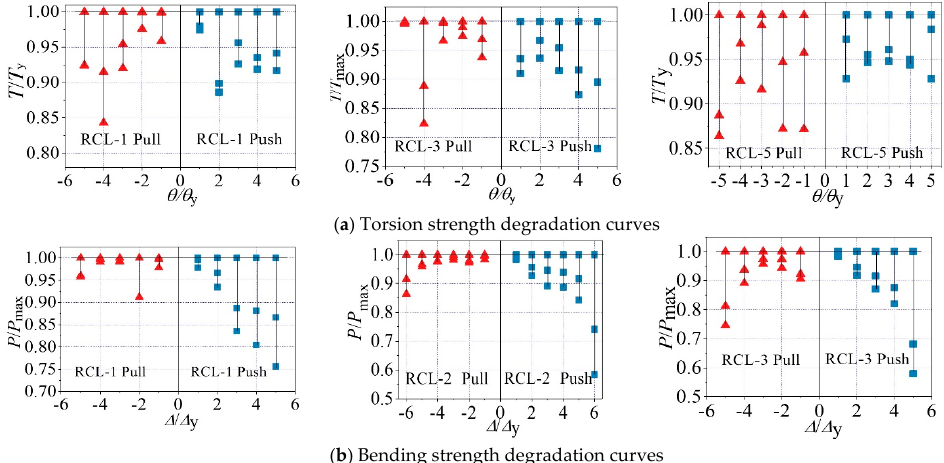
Figure 13. Strength degradation curves.